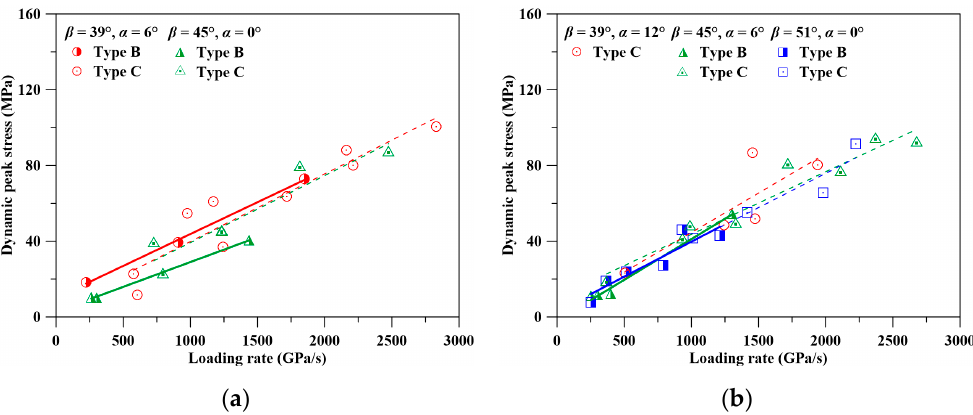
Figure 10. Relationship between dynamic peak stress/strength and loading rate of specimens with similar maximum angles of application of load on joint surface. ( a ) β = 45°, α = 0° versus β = 39°, α = 6°, ( b ) β = 51°, α = 0° versus β = 45°, α = 6° and β = 39°, α = 12°.